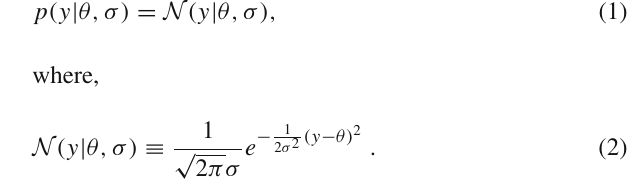
can be described as a Gaussian with central value θ and stan- dard deviation σ